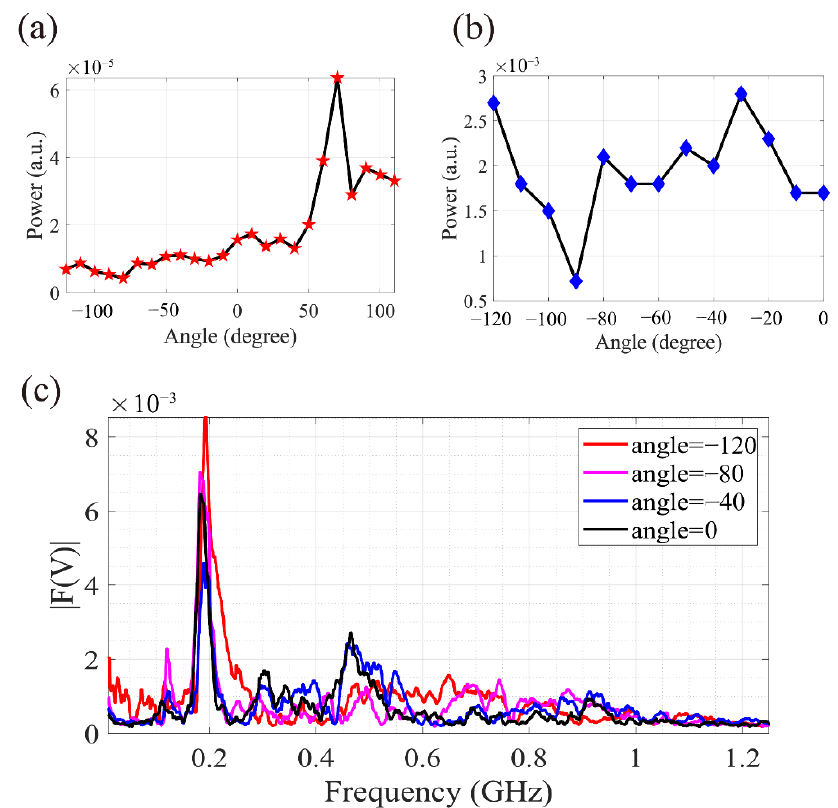
Figure 4. ( a ) Measured angular distributions of EMPs in the detection plane ( E = 100 mJ, t = 30 fs, d = 20 cm, and θ ranging from − 120° to 110°). ( b ) Measured angular distributions of EMPs in the detection plane ( E = 300 mJ, t = 30 fs, d = 30 cm, and θ ranging from − 120° to 0°). ( c ) Frequency-domain signals for different angles ( E = 300 mJ, the t = 30 fs, and d = 30 cm).